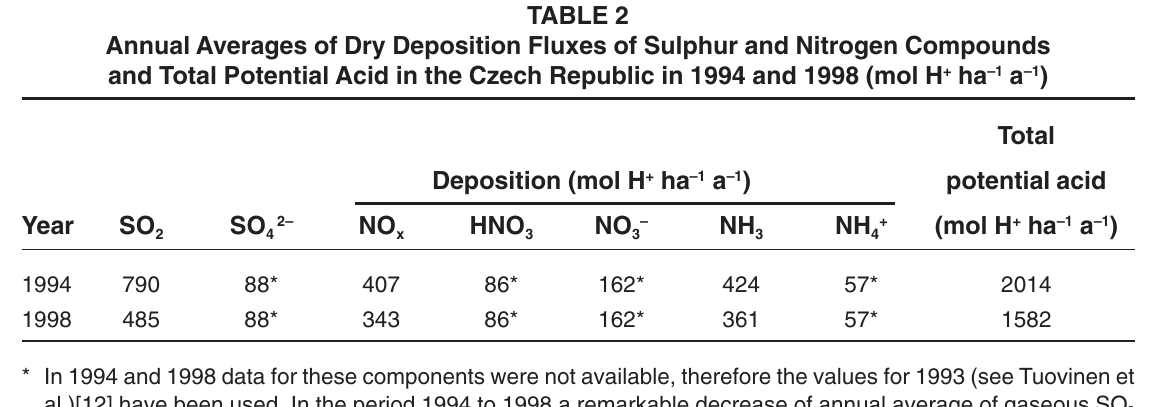
Annual Averages of Dry Deposition Fluxes of Sulphur and Nitrogen